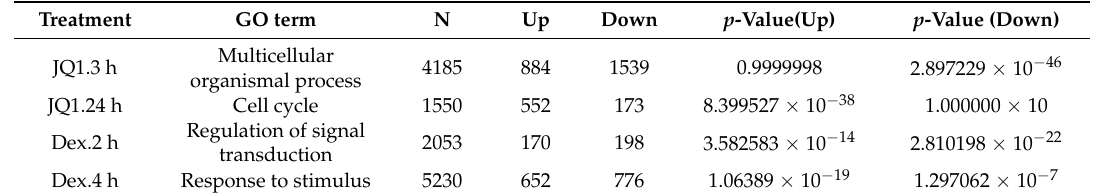
Table 3. Most significantly enriched Gene Ontology (GO) terms for different samples.